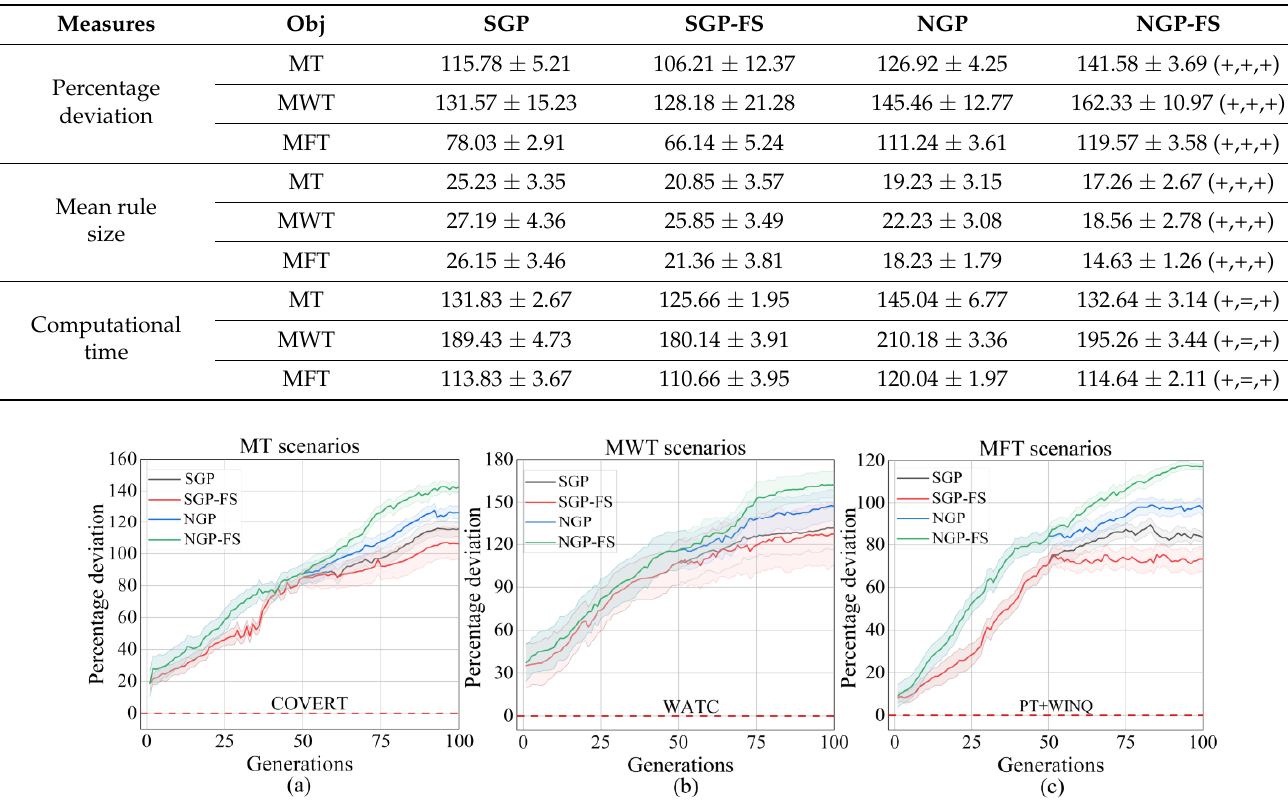
Table 5. Mean and standard deviation of the performance measures (training phase).